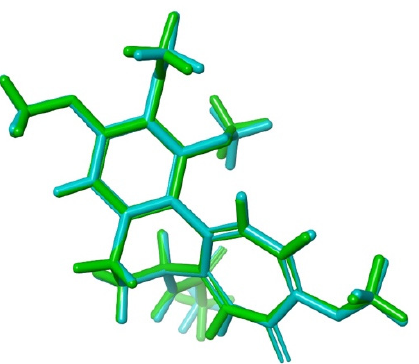
Figure 3. Superposition of the crystallized conformation (green) on the observed docked conformation (cyano)